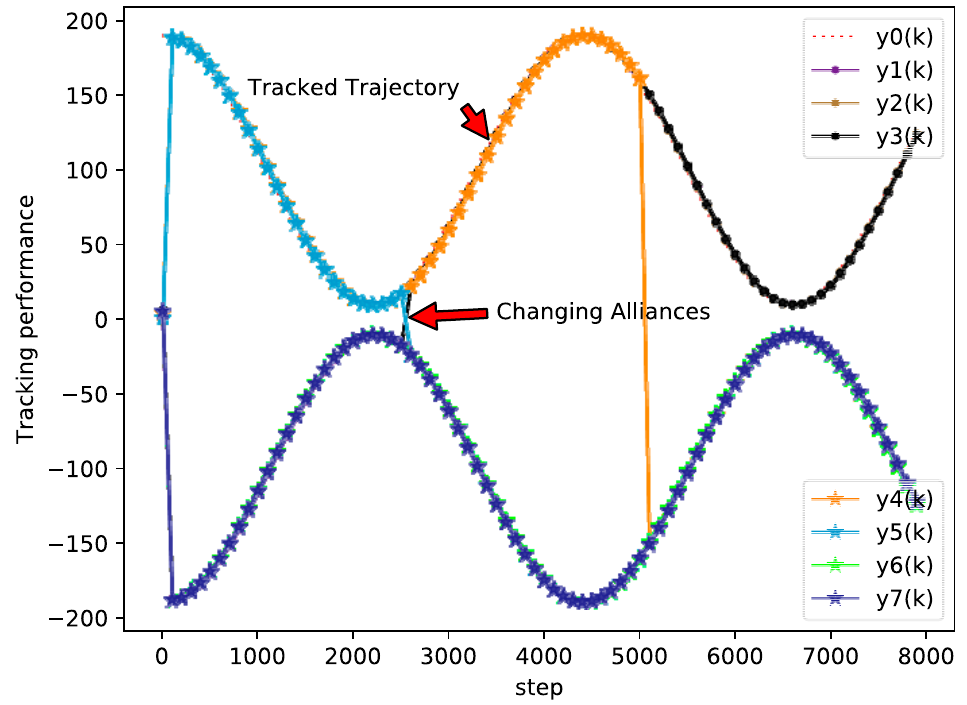
Figure 5. Tracking performance of each agent (example 2).